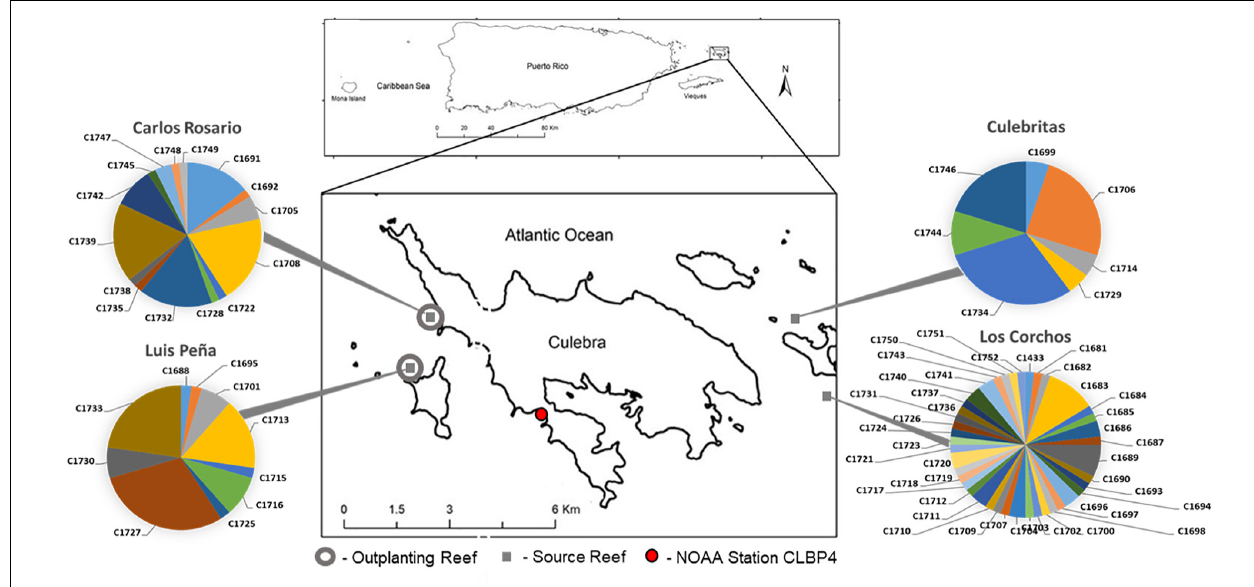
FIGURE 1 | Field experiment locations in Culebra, Puerto Rico. Four source sites are denoted with gray squares, Luis Peña (LP: 18 ◦ 18 (cid:48) 45.0 (cid:48)(cid:48) N, 65 ◦ 20 (cid:48) 08.4 (cid:48)(cid:48) W), Carlos Rosario (CR: 18 ◦ 19 (cid:48) 30.2 (cid:48)(cid:48) N, 65 ◦ 19 (cid:48) 52.7 (cid:48)(cid:48) W), Culebritas (18 ◦ 19 (cid:48) 19.4 (cid:48)(cid:48) N 65 ◦ 14 (cid:48) 14.5 (cid:48)(cid:48) W) and Los Corchos (18 ◦ 18 (cid:48) 33.0 (cid:48)(cid:48) N 65 ◦ 13 (cid:48) 44.3 (cid:48)(cid:48) W). The genotypic composition was obtained using 6 microsatellite loci as in Baums et al. (2005a) and is shown in pie charts. Outplant sites (gray circles) consisted of five 5 m × 5 m plots located at each site at two depths (5 and 15 m). A total of n = 20 fragments from each source site were outplanted in each plot for a total of n = 400 fragments. Temperature records were gathered from NOAA Data Buoy Center, Station CLBP4 (red circle) located 3.8 and 4 km from LP and CR respectively.